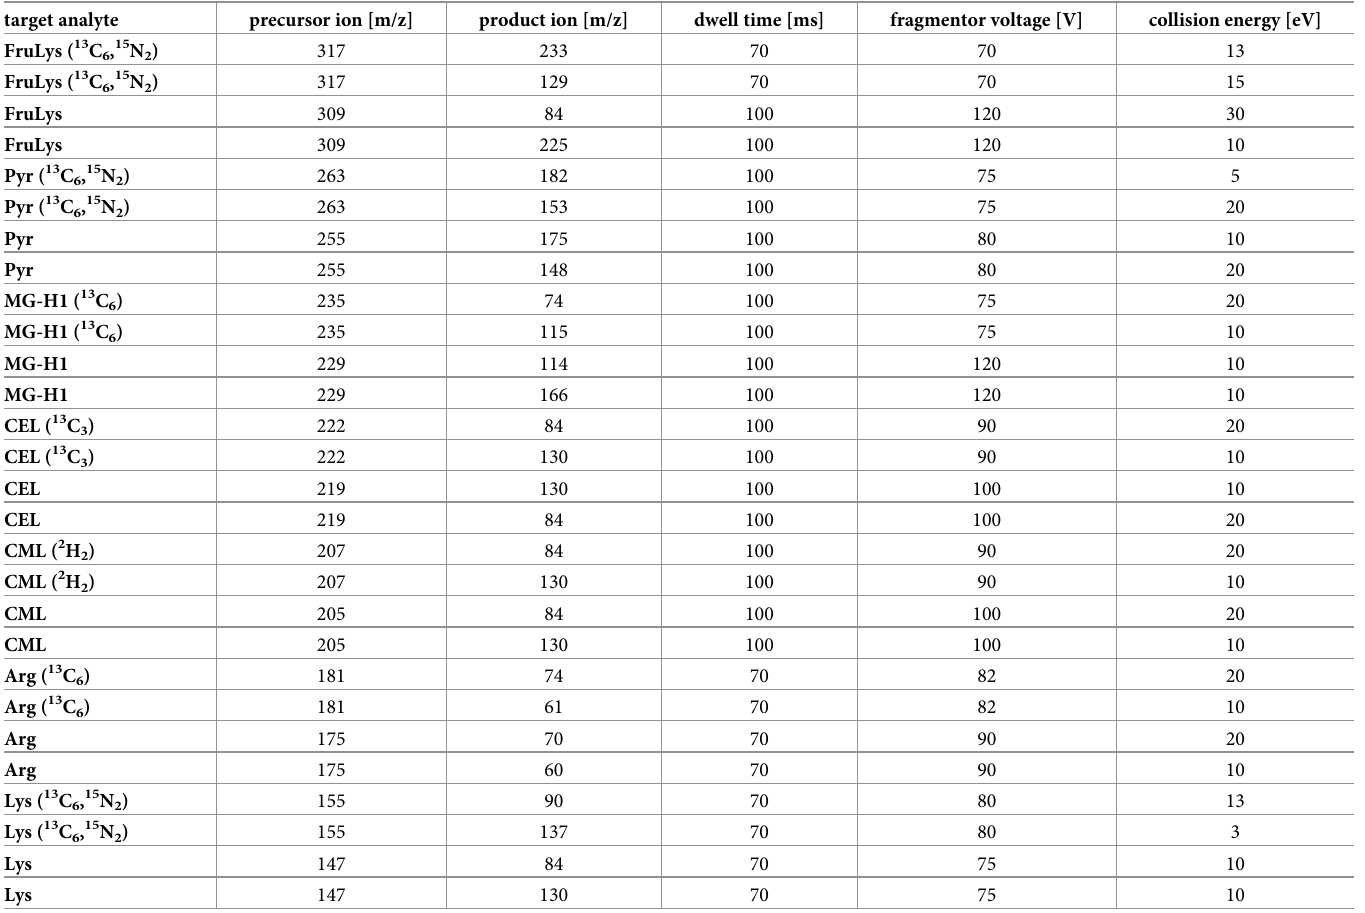
Table 1. Parameters for mass spectrometric detection of (glycated) amino acids after chromatographic separation. target